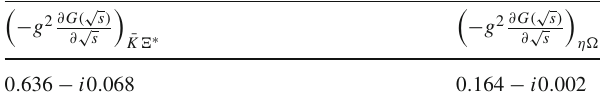
Table 4 Parameters from the fit to the experimental results with small